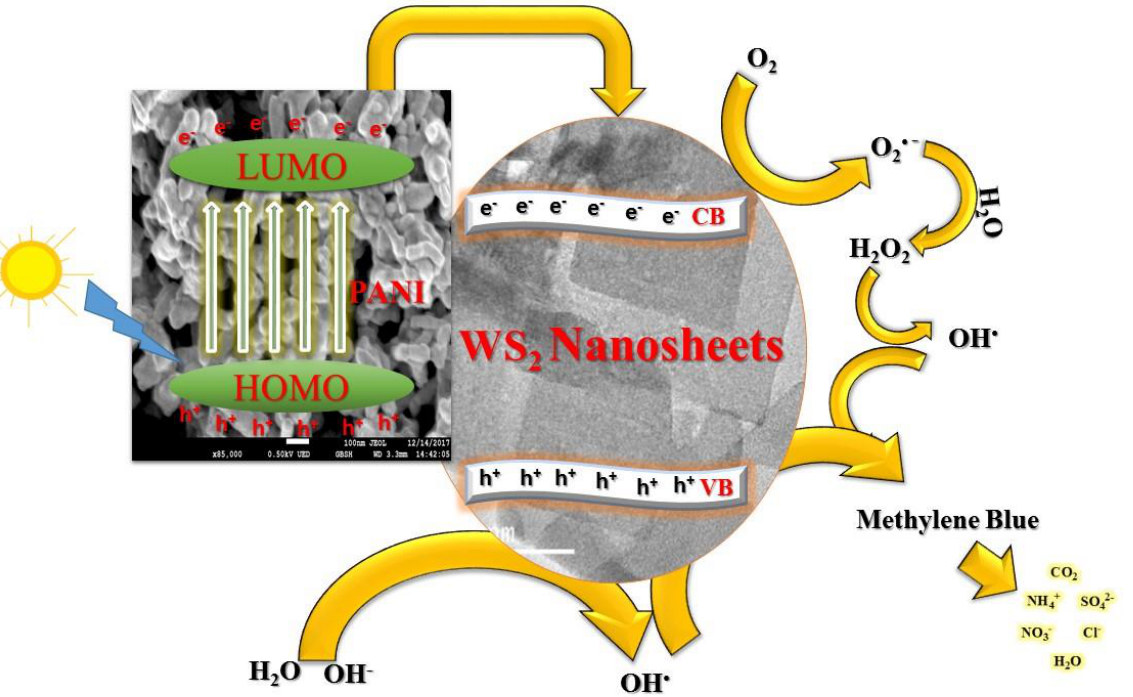
Figure 10. Mechanism for the methylene blue degradation via WS 2 -PNAI-5 nanocomposite